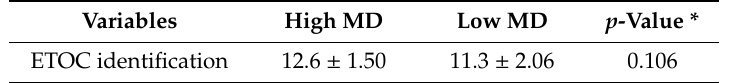
Table 3. Summary of MD profile on objective olfactory assessments (mean ± standard deviation).